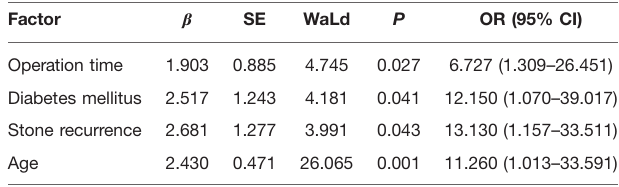
TABLE 4 | Factors affecting the changes of gallbladder contractile function.